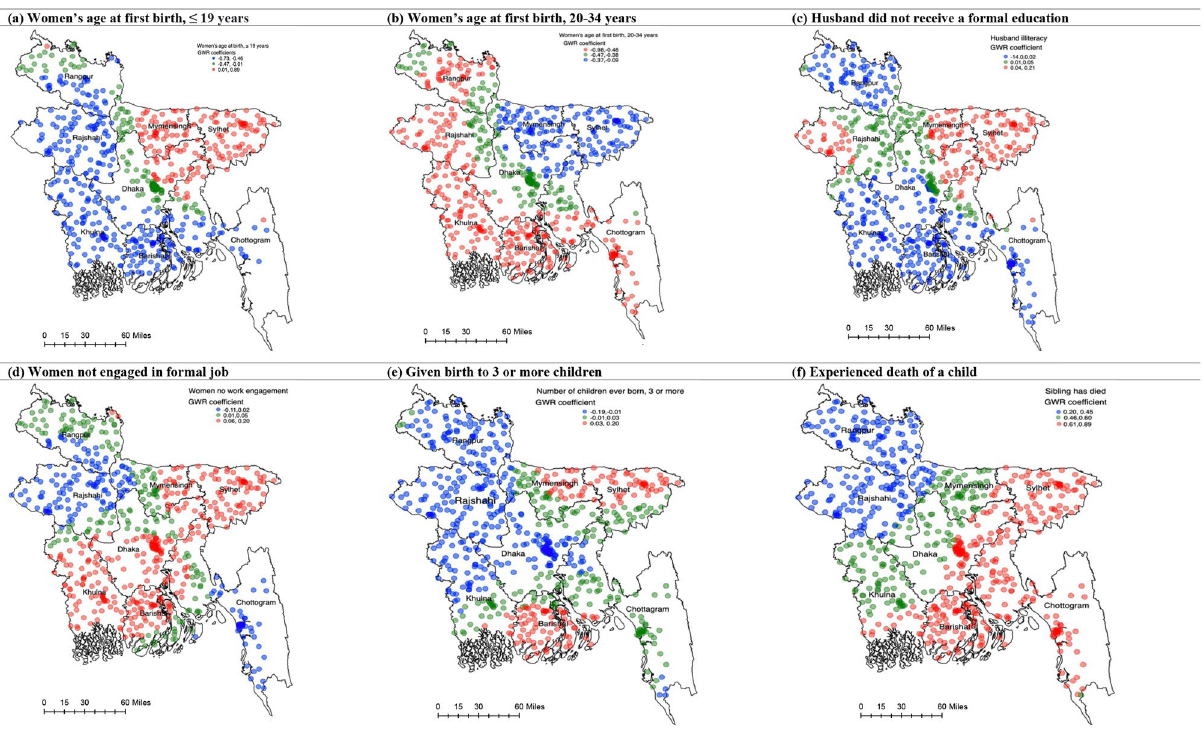
Figure 3. ( a – f ) GWR coefficients predicting short birth intervals in Bangladesh, BDHS